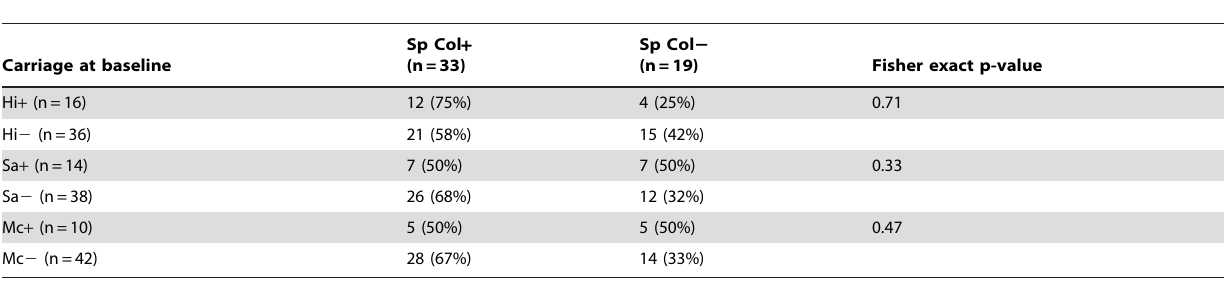
Table 2. Contingency tables of carriage of Hi, Sa, and Mc at baseline against colonization with Sp post-inoculation for 52 subjects.